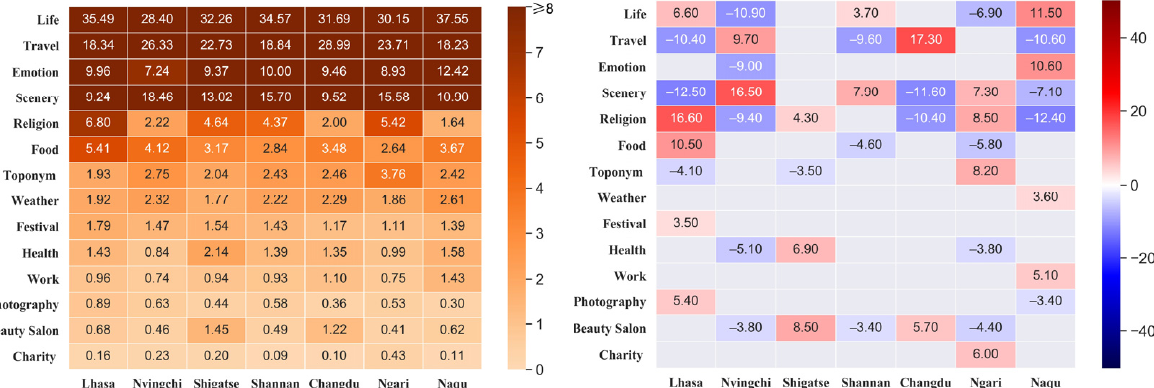
Figure 8. Distributions and adjusted standardized Chi-square residuals for the top 20 topics in the Tibetan tourist dataset by city (unit: %).